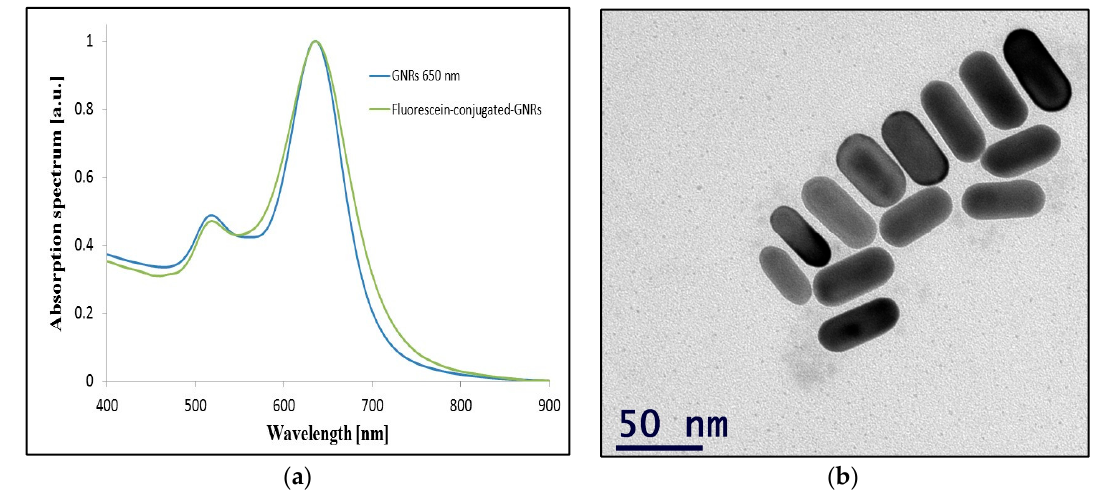
Figure 8. GNRs characteristics: ( a ) GNRs normalized absorption spectrum; ( b ) GNRs TEM image.